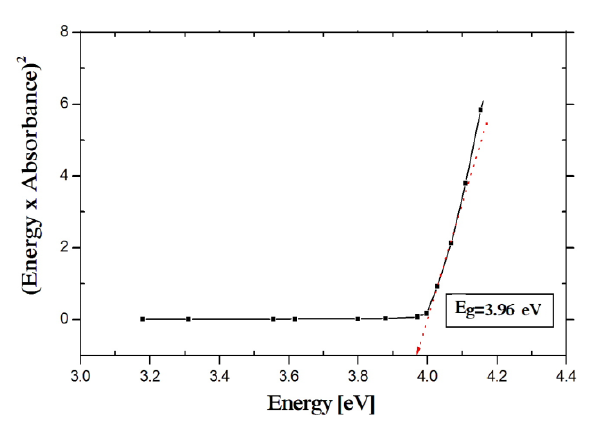
(2,9-dimethyl-1,10-phenanthroline)·H 2